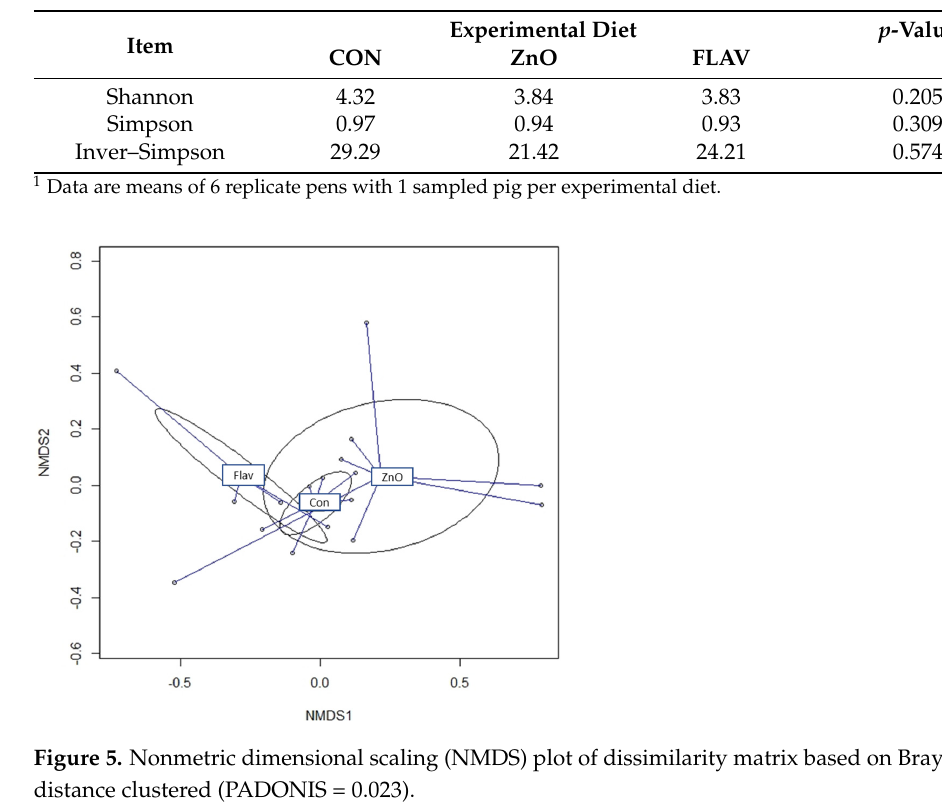
Figure 4. Gene expression of TAS2R of pigs fed the experimental diets analyzed by tissue. * Means statistically different ( p < 0.05).